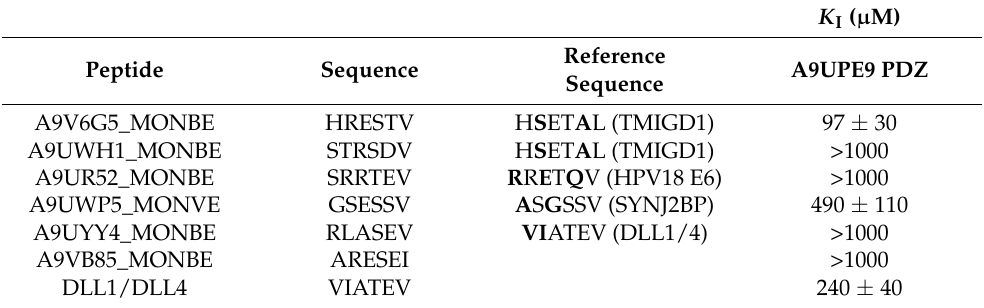
Table 4. Binding affinities for A9UPE9 PDZ with M. brevicollis sequences, determined by fluorescence polarization experiments. The reference sequence for Motif Matcher is included, where applicable. Experiments conducted as in Table 3 and as described in the Materials and